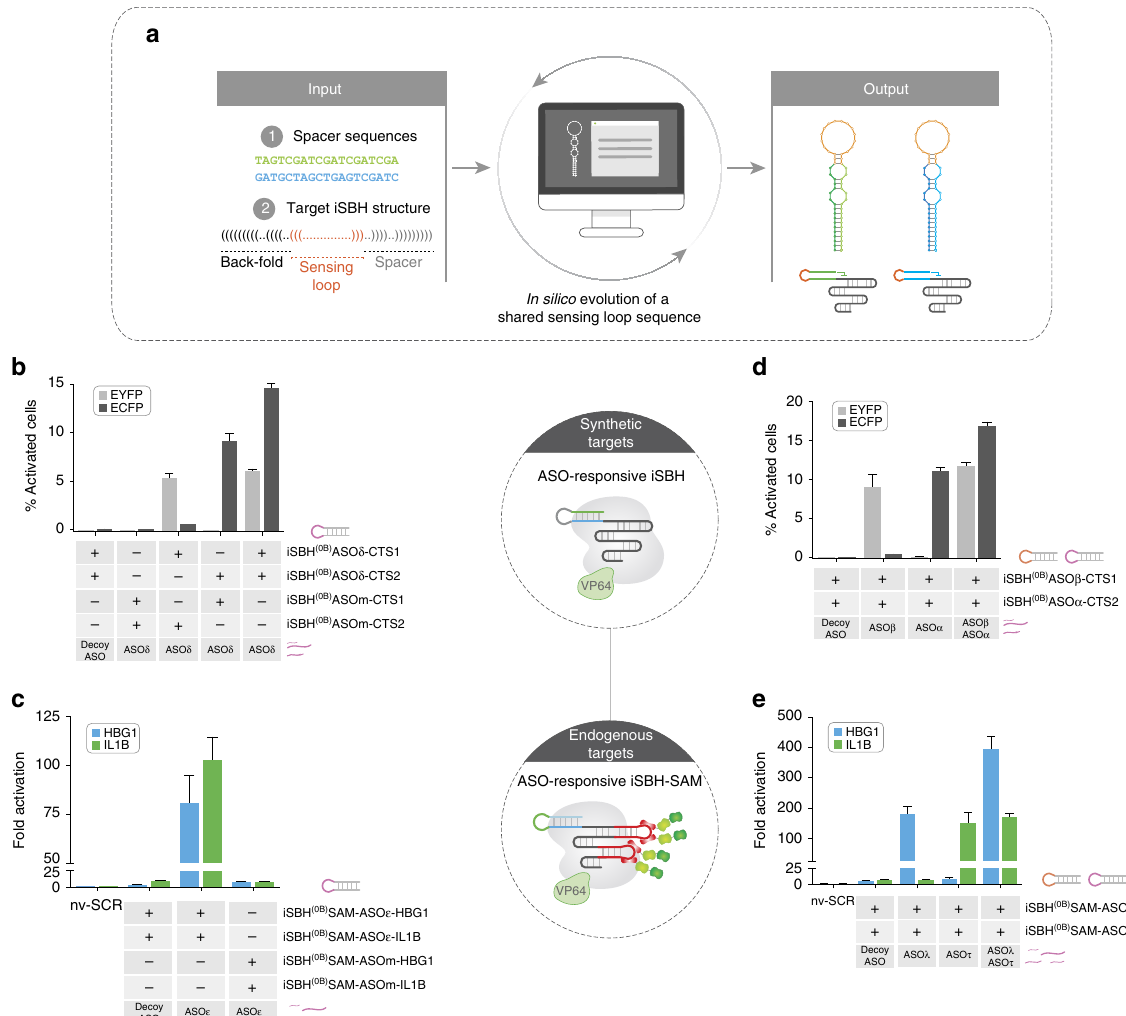
Figure 5 | Assembly of gene network modules with ASO-responsive iSBH sgRNAs. ( a ) Schematic of the iSBHfold algorithm. Based on user-specified spacer sequences and desired iSBH secondary structure, the software employs a genetic algorithm to evolve a pool of potential ASO sensing loops. The resulting sequences are compatible with optimal iSBH structures across multiple spacers. ( b ) Parallel activation of target genes using ASO-responsive iSBH-sgRNAs (branching module). iSBH (0B) ASO d -CTS1 and iSBH(0B)ASO d -CTS2 containing a shared sensing loop were co-transfected with dCas9-VP64 and the dual-reporter system. Decoy ASO or trigger ASO d were delivered to cells 24h post transfection. Parallel experiments using iSBH-sgRNAs with mutant sensing loops (iSBH (0B) ASOm-CTS1 and iSBH (0B) ASOm-CTS2) were carried out to confirm the specificity of the observed effects. ( c ) Conditional overexpression of HBG1 and IL1B using a single ASO. iSBH (0B) SAM-ASO e -HBG1 and iSBH (0B) SAM-ASO e -IL1B responsive to a shared trigger ASO e were used to implement a branching module. Delivery of ASO e at 24h post transfection resulted in an increase in transcript levels for both genes compared with nv-SCR control, a decoy ASO or iSBH-sgRNAs containing mutant sensing loops (iSBH (0B) SAM-ASOm-HBG1, iSBH (0B) SAM-ASOm-IL1B). ( d ) Implementation of an orthogonal gene activation module using ASO-responsive iSBH-sgRNAs. iSBH (0B) ASO b -CTS1 and iSBH (0B) ASO a -CTS2 containing distinct sensing loop were supplemented 24h post transfection with a decoy ASO, ASO b , ASO a or a combination of ASO b þ ASO a . ( e ) iSBH (0B) SAM-ASO l -HBG1 and iSBH (0B) SAM-ASO t -IL1B containing different ASO-sensing loops were supplemented with decoy ASO, ASO l , ASO t or a combination of ASO l þ ASO t . Orthogonal regulation of HBG1 and IL1B transcription was observed in the presence of matching ASOs compared with a control nv-SCR sgRNA. For ( b , d ) n ¼ 3 biological replicates for each condition (mean ± s.d.). Quantification of cell fractions expressing EYFP, ECFP or both EYFP and ECFP relevant to conditions in b , d is displayed in Supplementary Fig. 8. For ( c , e ) n ¼ 3 biological replicates ( (cid:2) 3 technical replicates) (mean ±